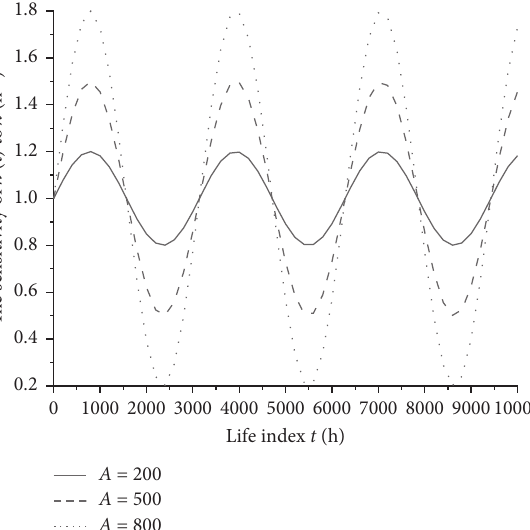
Figure 25: The sensitivity of f ( t ) to λ ( A � 200/500/800).